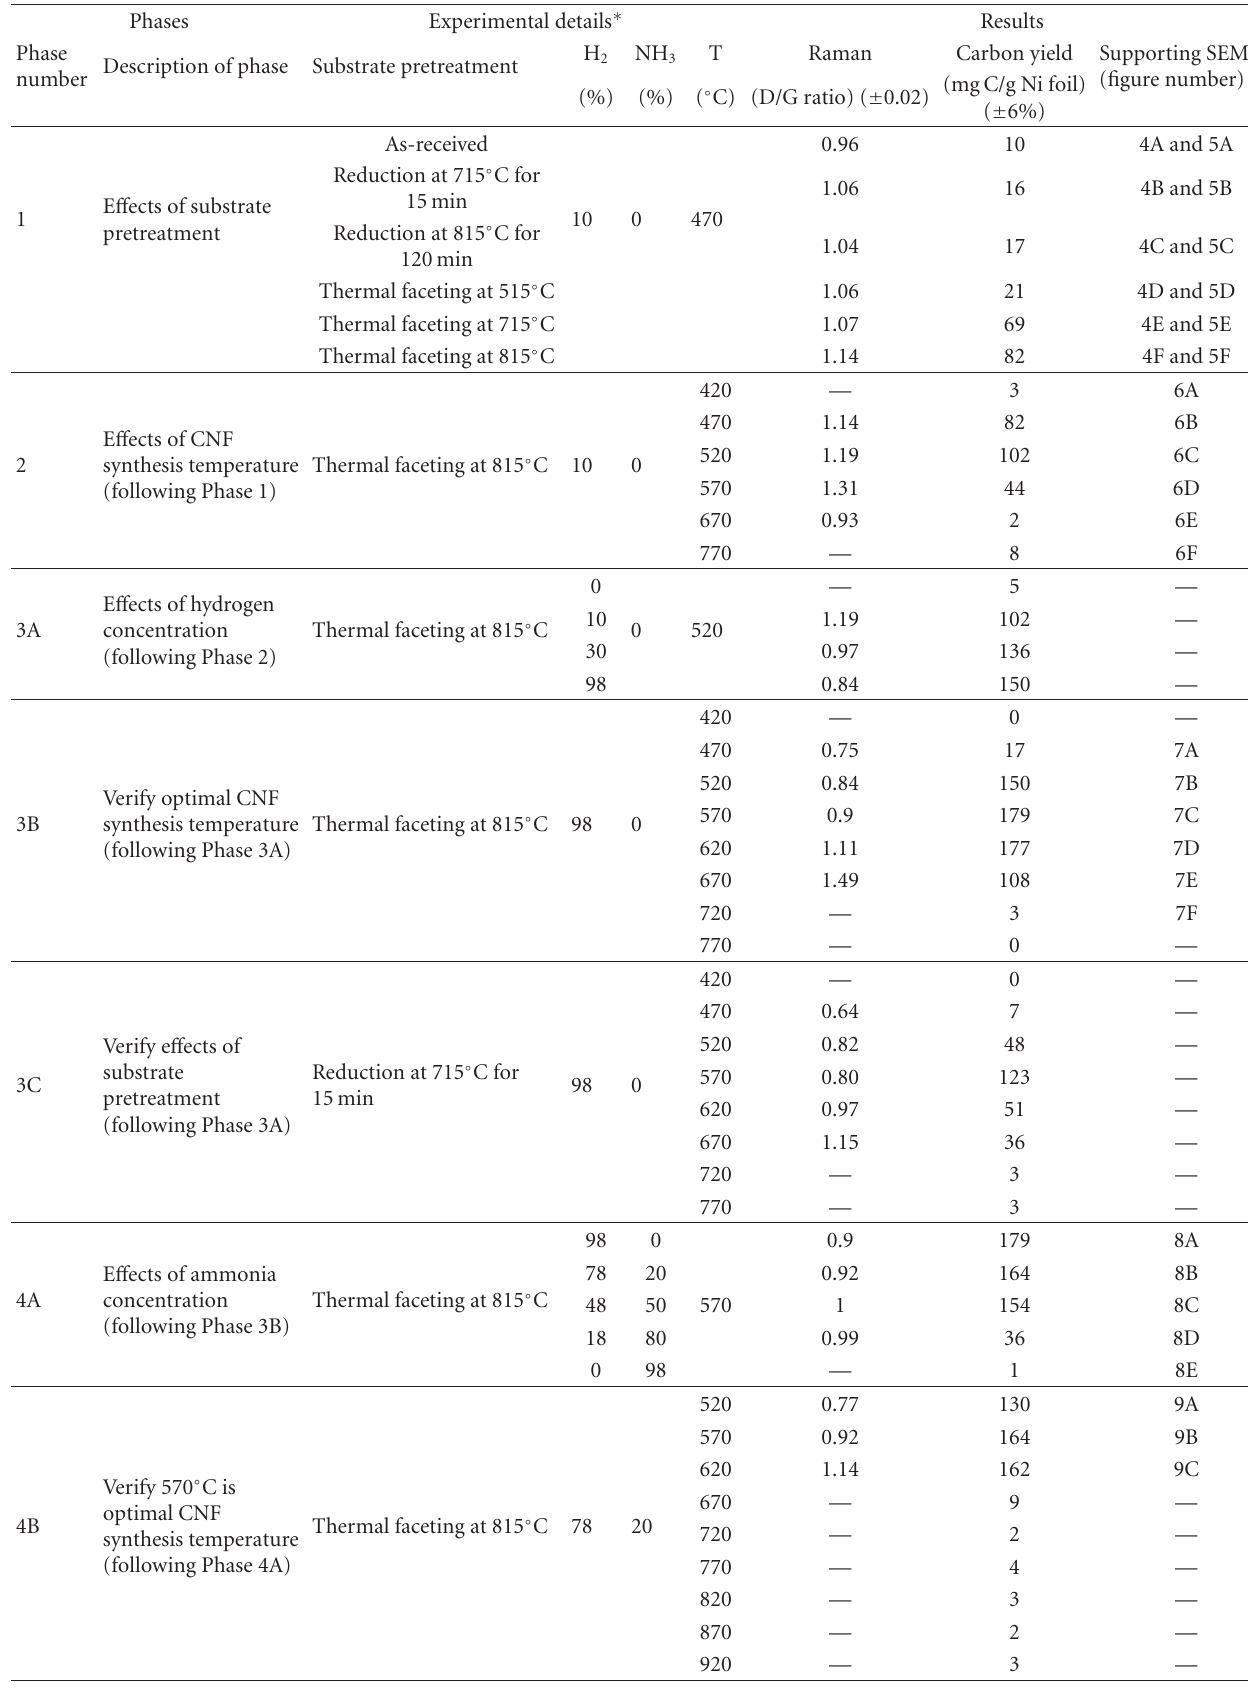
Table 1: Sequence of CNF synthesis optimization e ff orts on nickel foil